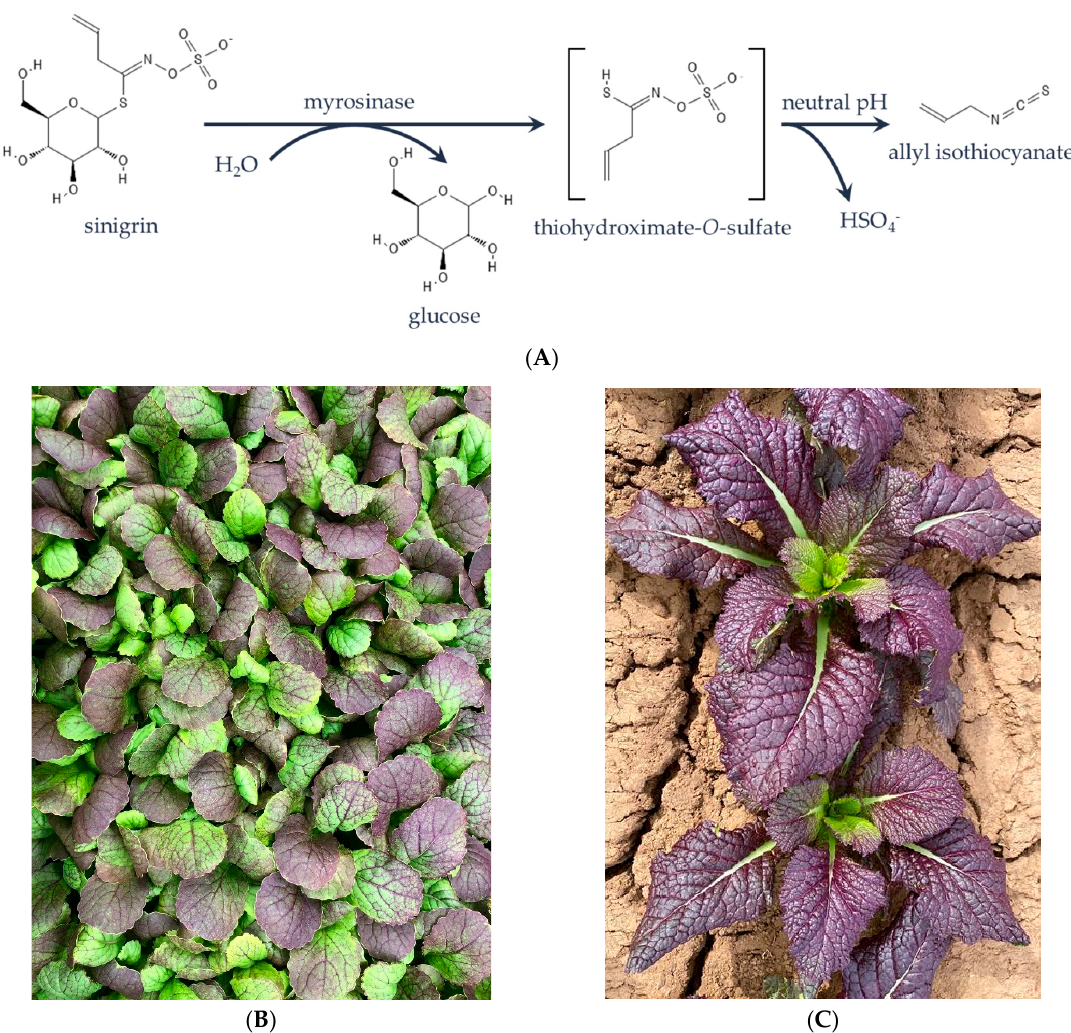
Figure 1. The ‘mustard bomb’ reaction ( A ) with sinigrin as the glucosinolate hydrolyzed by myrosi- nase. Brassica juncea cv. Red Giant ( B ) baby (average leaf length of 10 cm and width of 5 cm) and ( C ) mature plants (average leaf length of 25 cm and average leaf width of 20 cm).